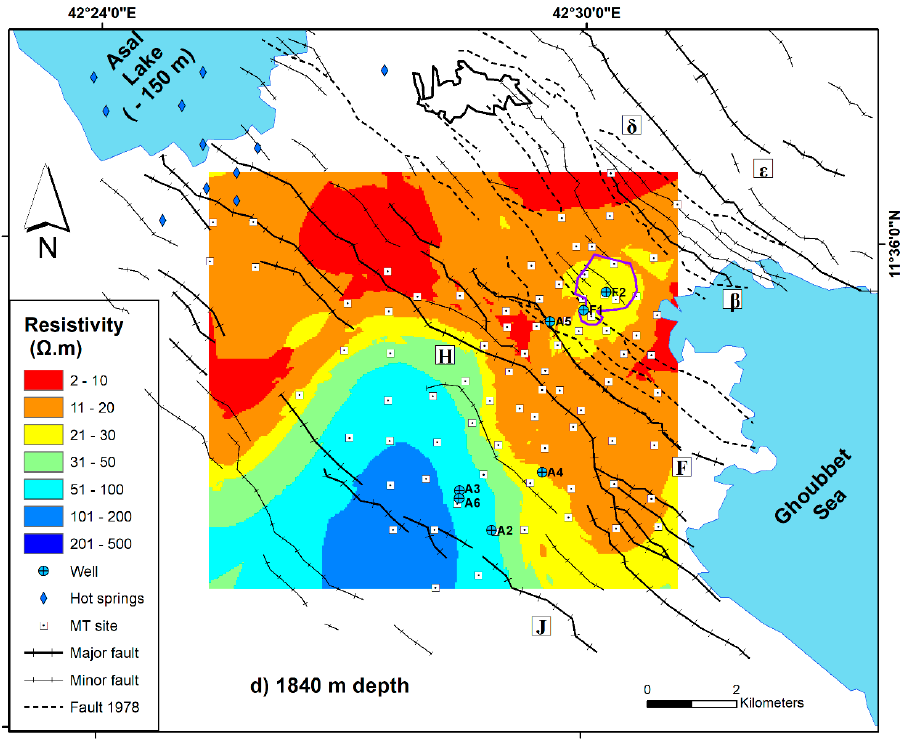
Figure 4. Interpolation at selected depth of inverted electrical resistivity.